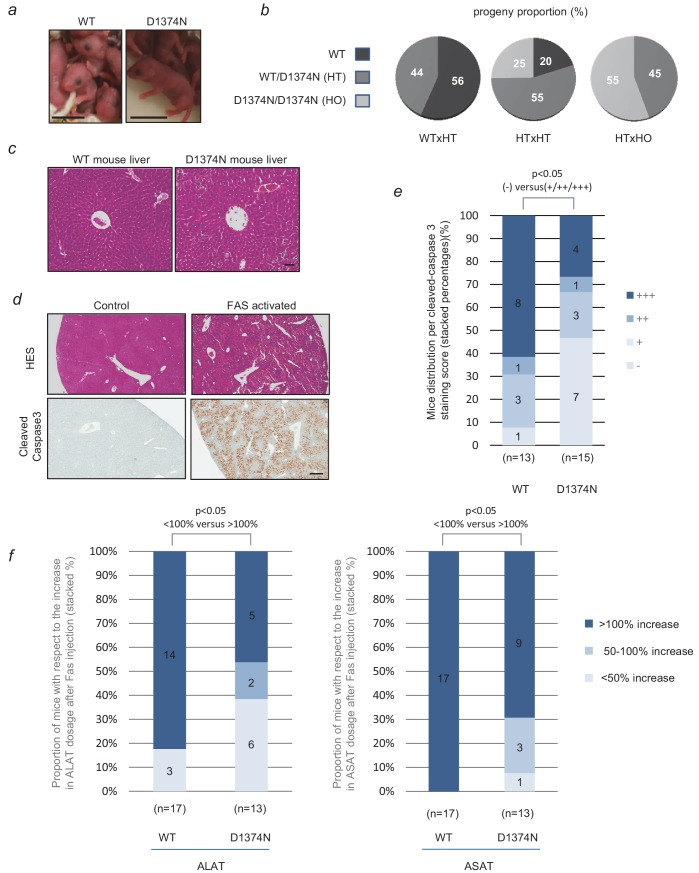
Evaluation of hepatocytes apoptosis in WT and D1374N mice.(a) Pictures of newborn wild-type (WT) and MET D1374N mice; scale bar = 1 cm. (b) Pie chart representation of the proportions of WT, heterozygous (HT) and homozygous (HO) progeny obtained by crossing mice with different genotypes. (c) WT and MET D1374N mouse liver sections stained with hematoxylin/eosin, showing a hepatic lobule with a centro-lobular vein at the center; scale bar = 50 µm. (d) Example of hematoxylin/eosin and cleaved-caspase 3 staining (brown) in the livers of WT mice pretreated before the experiment with 100 µl of 5 mg/ml Crizotinib and then treated for 4 hr with Jo-2 antibody against FAS (4 µg/20 g mouse weight); scale bar = 300 µm. (e) WT and D1374N mice were treated as reported in (d). The total liver area and cleaved caspase-3 staining area were quantified for each slide. The data represent the distribution of cleaved-caspase 3 staining scores (-: 0% to 2%; +: 2% to 5%; ++: 5% to 10%; +++:>10%). In each column, the number of mice obtaining each score is indicated. Statistical analysis applied to differences in negative (-) and positive (+, ++ and +++) staining between WT and D1374N. p<0.05 was determined by Fisher test (WT: n = 13; D1374N: n = 15). (f) WT and D1374N mice were treated as reported in (d). Blood samples were collected just before and 4 hr after Jo-2 antibody treatment. The graphs represent the distribution of the evolution of plasma ALAT (left) or ASAT (right) levels between these 2 time points (up to 50% increase, 50–100% increase or more than 100% increase). Statistical analysis applied to differences in <100% increase and >100% increase between WT and D1374N. p<0.05 was determined by Fisher test (WT: n = 17; D1374N: n = 13).Figure 6—source data 1.Source data of Figure 6e reporting percentage of active caspase 3 in liver IHC, repartition in staining score (-;+;++;+++), computation of the percentages, diagram conception and statistical analyses; source data of Figure 6f reporting ALAT and ASAT concentration in mouse blood, relative increase, diagram conception and statistical analyses.